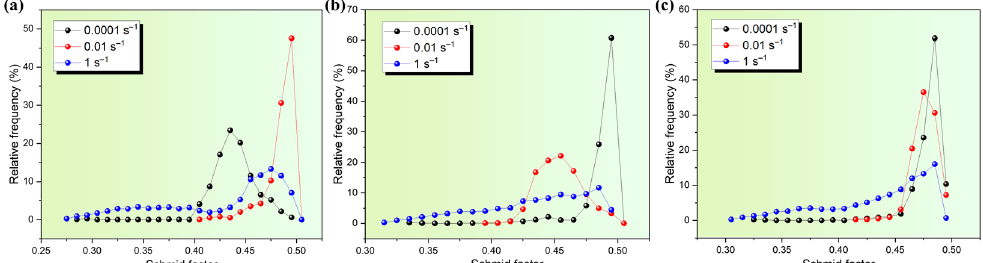
Figure 13. Relative frequency of SF values for different slip systems of TB6 titanium alloy compressed at 740 °C and different strain rates: ( a ) {1 − 10}<111>; ( b ) {11 − 2}<111>; ( c ) {12 − 3}<111>.